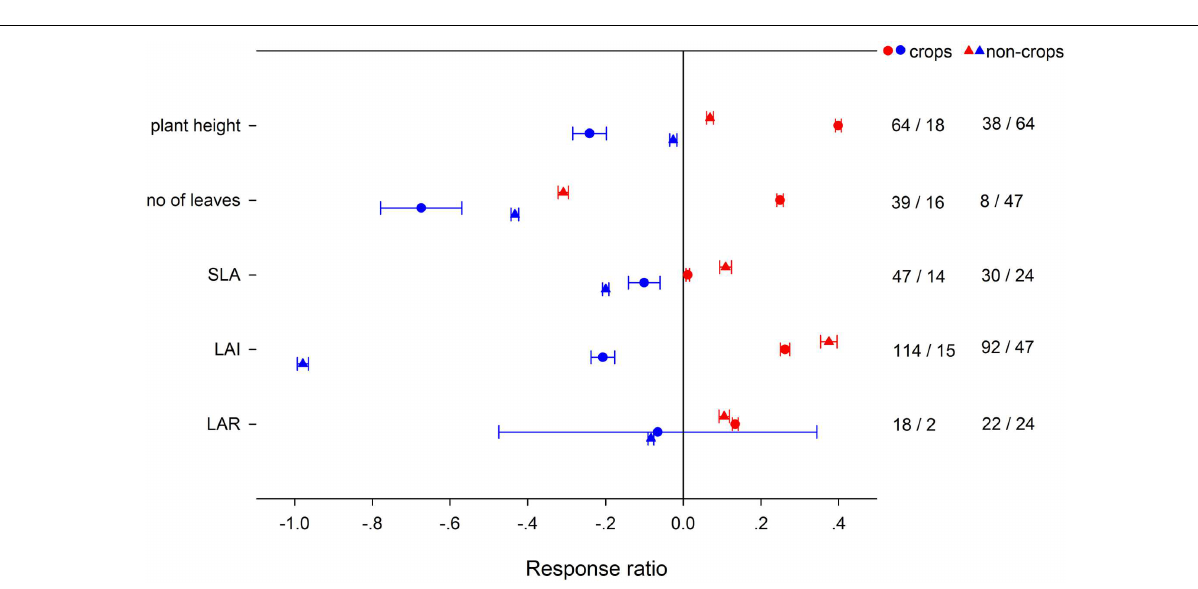
FIGURE 5 | Plant morphological responses to HNT (red) and LNT (blue) in crops (circles) and non-crops (triangles) species. Each data point represents the mean ± 95% CI. The number of observations for each variable is given on the right of the